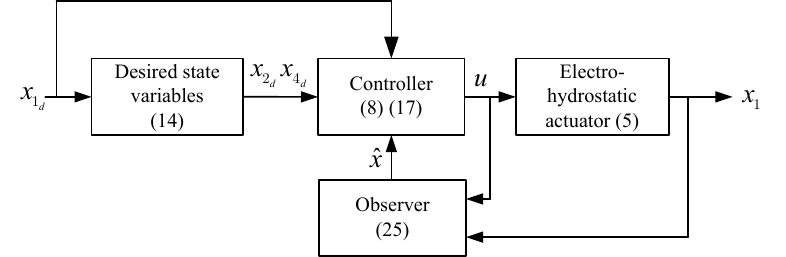
Figure 2. lock diagram of the controller